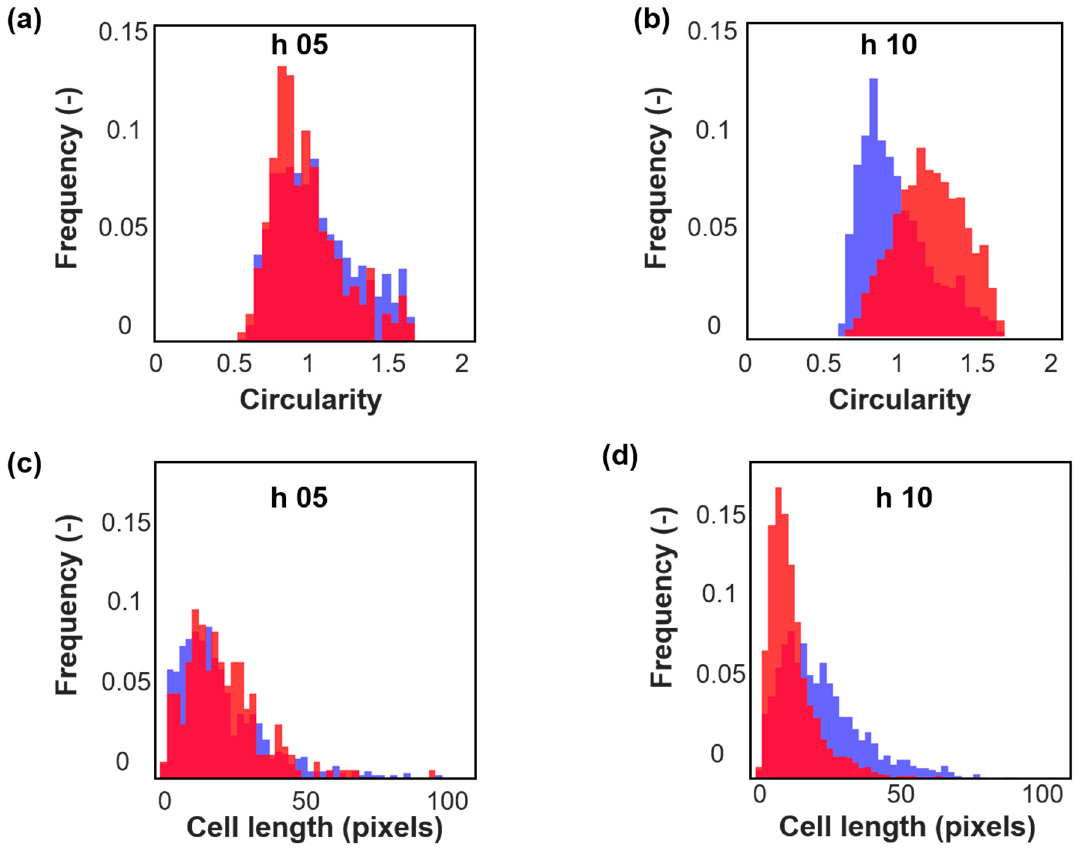
Figure 5. Normalized histograms for ( a ) circularity, 5th hour samples; ( b ) circularity, 10th hour samples; ( c ) cell length 5th hour samples; and ( d ) cell length 10th hour samples from one representative pH-A (blue) and pH-B (red) batch.